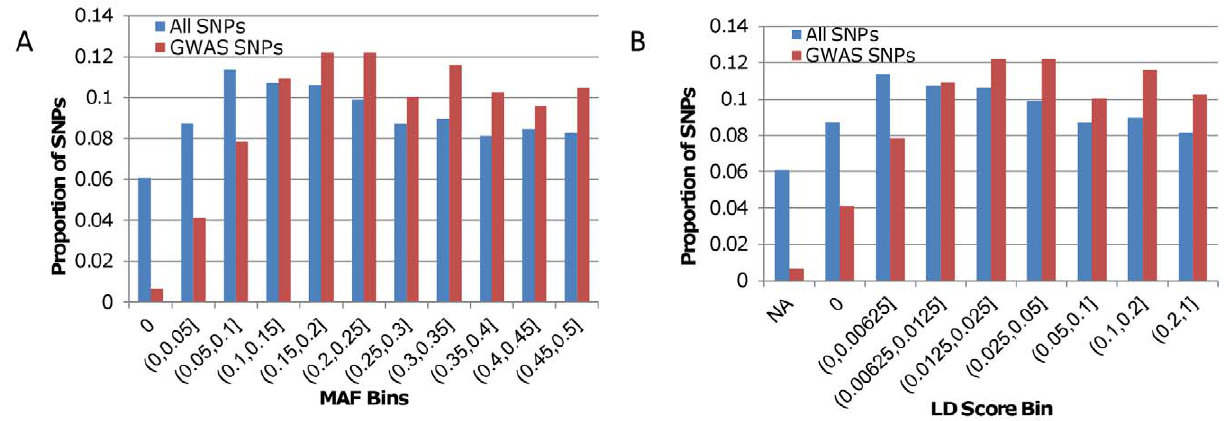
Figure 1. Histograms of SNP MAF and LD score in Europe. A) The blue bars represent the proportion of the 640,698 autosomal SNPs in the Li et al. [12] dataset that have a European MAF in each MAF bin (see Methods). The red bars represent the proportion of the 1,336 GWAS SNPs that have a European MAF in each MAF bin. B) The blue bars represent the proportion of the 640,698 autosomal SNPs that have an LD score in each LD score bin (see Methods). The red bars represent the proportion of the 1,336 GWAS SNPs that have an LD score in each LD score bin. The bin referred to as ‘‘NA’’ contains all SNPs that are fixed in Europe.